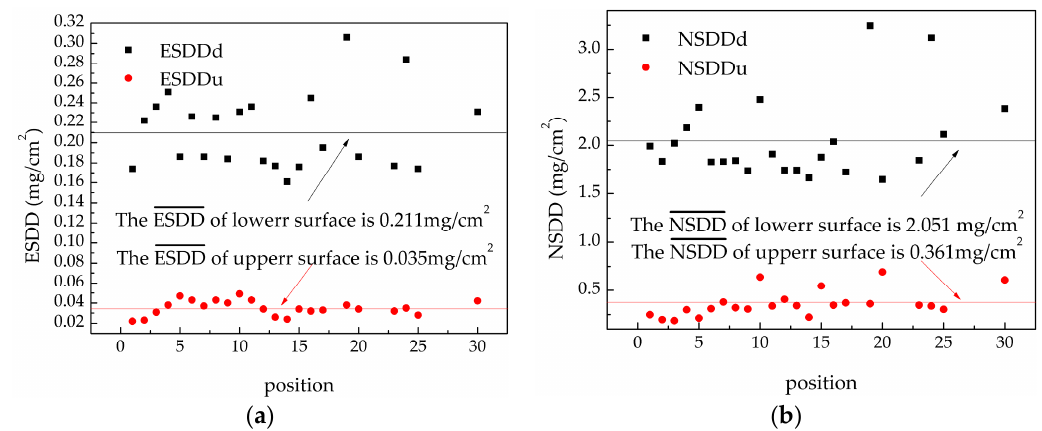
The ESDD and NSDD of the insulators in the positive polar of DC transmission line are shown